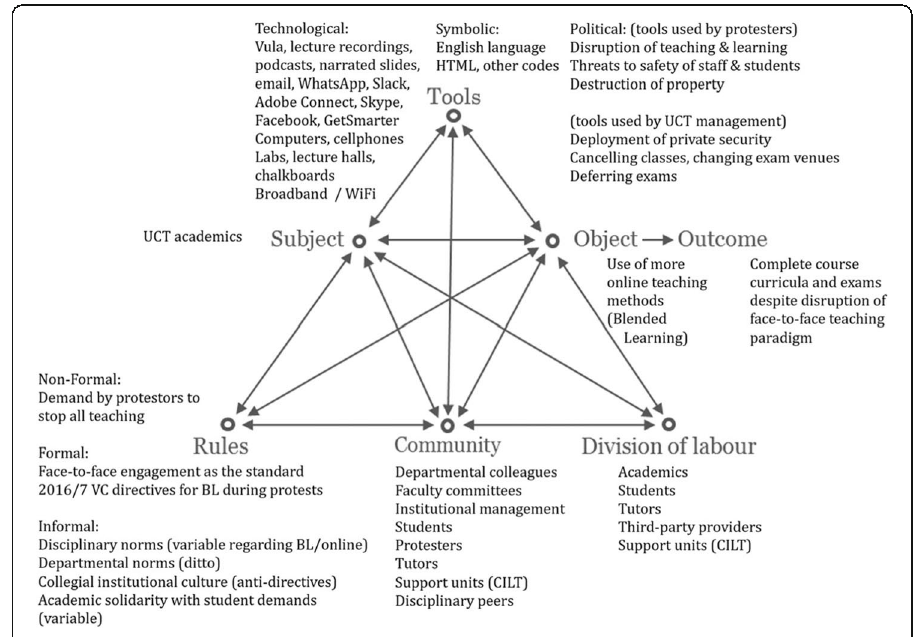
Fig. 2 UCT blended learning activity